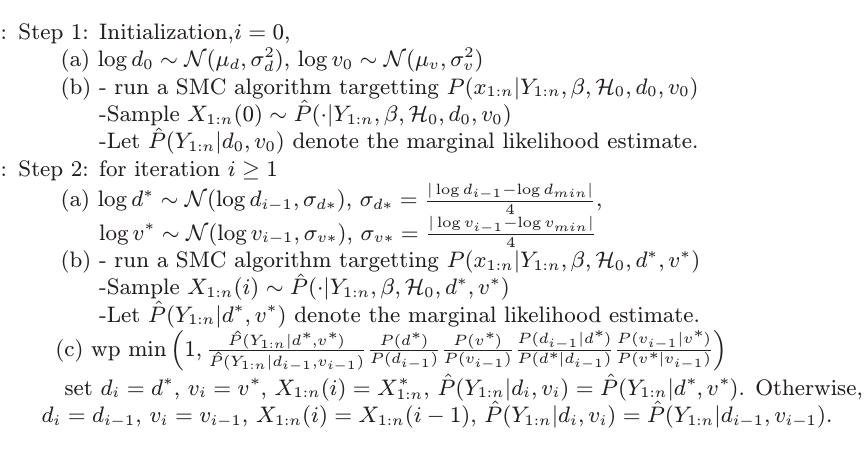
Algorithm 6 Estimating the weekly observed cases